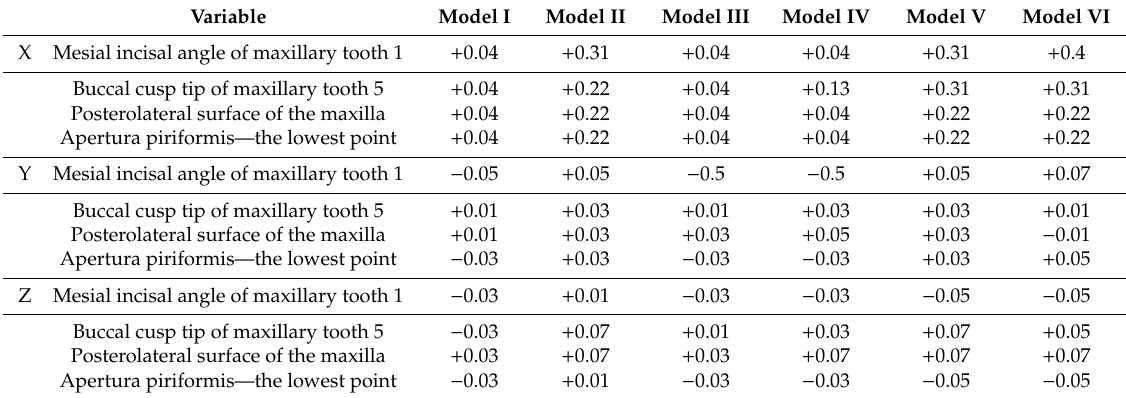
Table 4. Displacement values of selected anatomical structures (mm) along the X, Y, Z, with various surgical procedures and tooth born orthodontic appliance using finite element